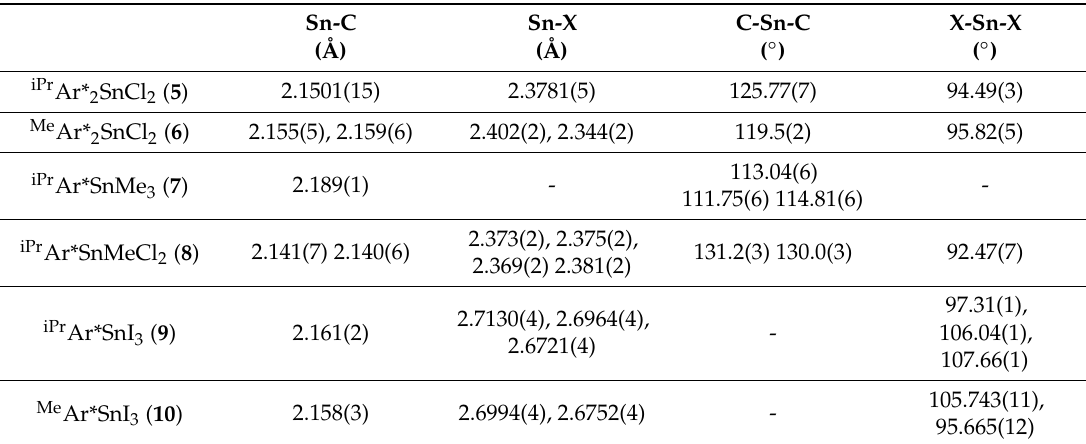
Figure 6. Solid state structures of ( a ) 5 , ( b ) 9 and their corresponding tin hydride compounds ( c ) 11 , ( d ) 13 . All nonhydrogen atoms shown as 30% shaded ellipsoids. Hydrogen atoms except for those bonded to Sn are omitted for clarity. Selected bond lengths (Å) and angles ( ◦ ) are displayed in Tables 2 and 3. Table 2. Selected bond lengths (Å) and angles ( ◦ ) of aryltin compounds 5 , 6 , 7 , 8 , 9 as well as 10 (X = Cl,